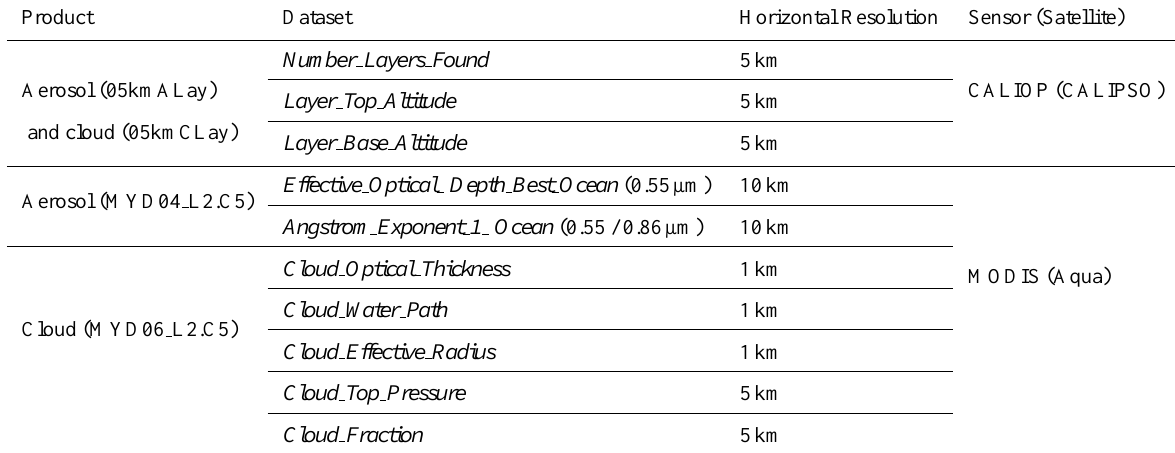
Table 1. Level 2 product used to characterise cloud and aerosol properties from MODISCALIPSO coincident retrievals. Product